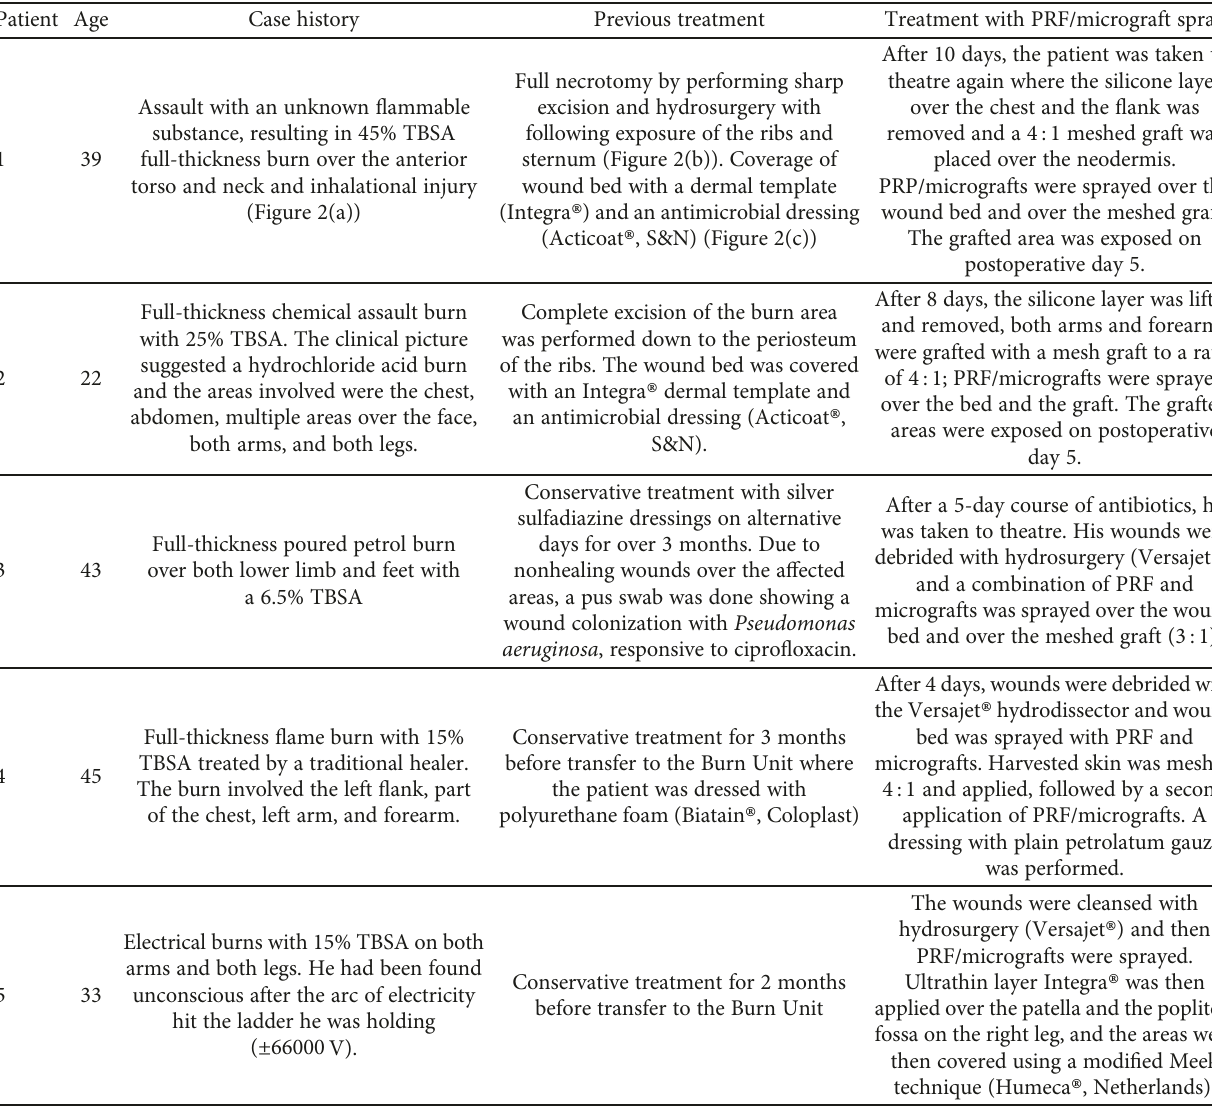
Table 1: Clinical characteristics of fi ve patients enrolled with the indications of previous treatments and application of PRF/micrograft spray- on